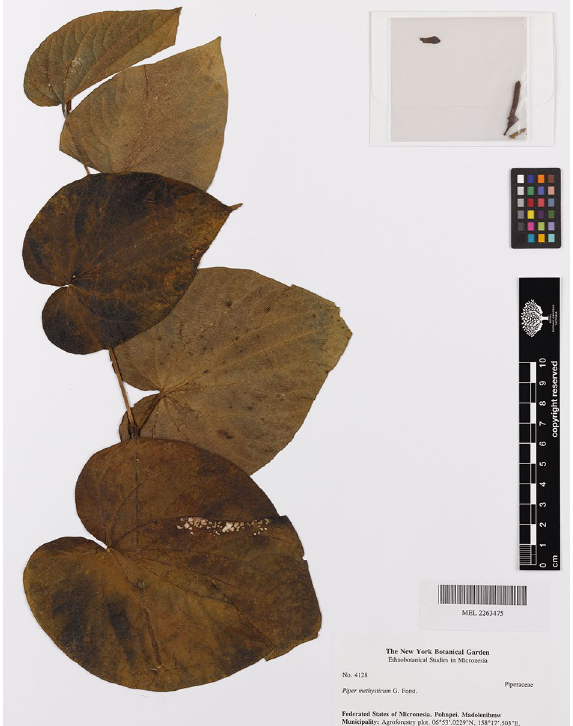
Figure 1. Piper Methysticum specimens. Piper Methysticum pressed plant specimens from the collection of the National herbarium of Victoria collection. Images were captured with a Leaf Aptus ‐ II 10 Digital Back camera. Reproduced with permission from the Royal Botanic Gardens